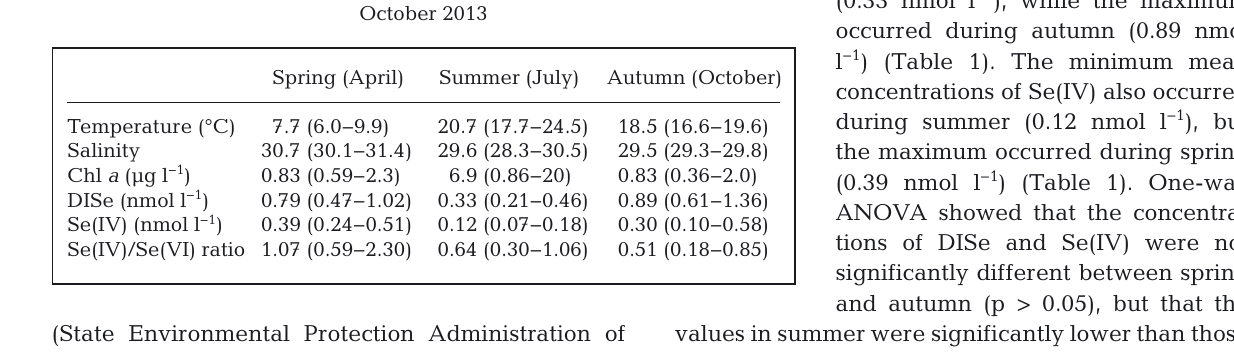
Table 1 that mean concentrations of DISe and Se(IV)